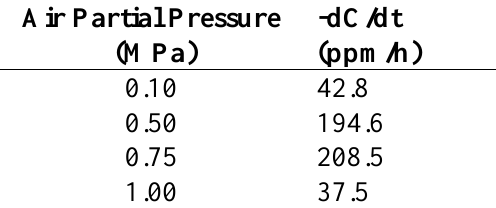
near critical conditions 2